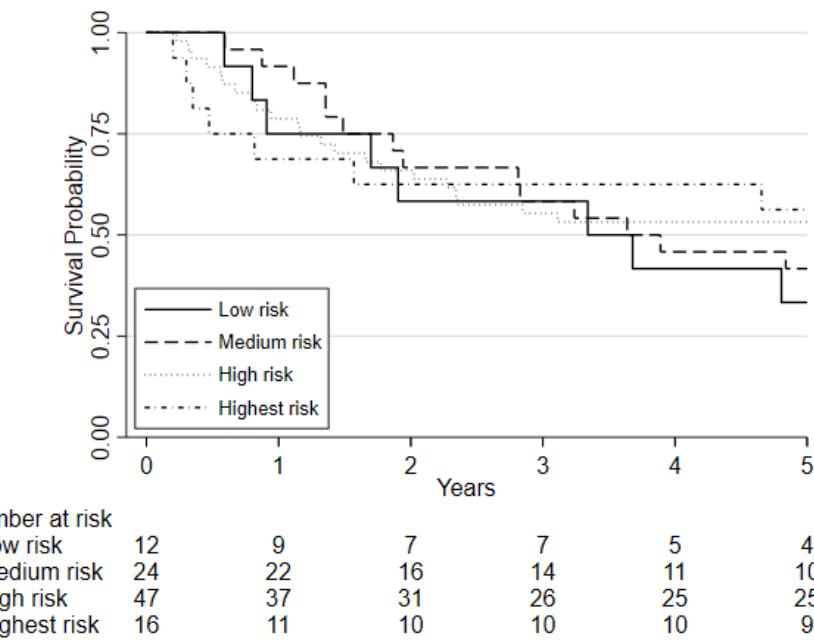
Figure 4. Kaplan-Meier plot of the estimated overall 5-year survival among patients with oesophago-gastric cancer who underwent CPET pre-and post-NAC/CRT followed by surgery, based on their post-chemo/chemoradiotherapy (NAC/CRT) VO AT risk stratification category. Predefined risk stratification categories were defined as low risk VO VO